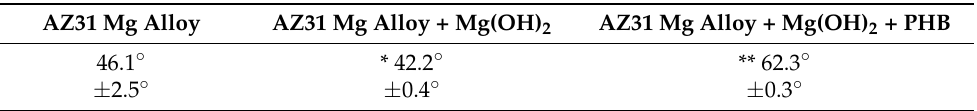
Table 2. Water contact angles for AZ Mg alloy not hydrothermally treated (first column), hydrother- mally treated with the formation of a Mg(OH) 2 surface coating (second column), and hydrothermally treated with an additional PHB coating (third